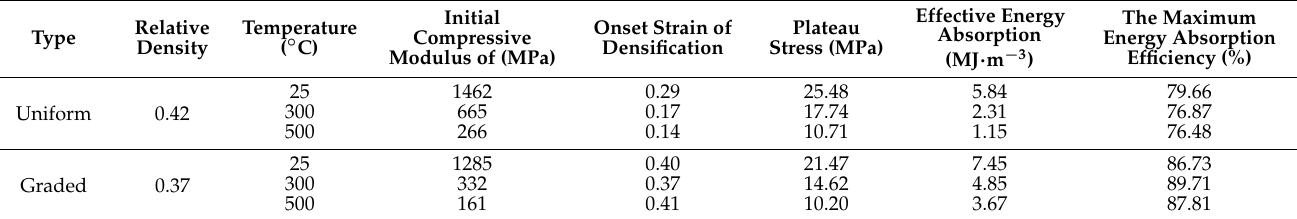
Table 1. Compressive properties of the uniform and graded CCCFs.